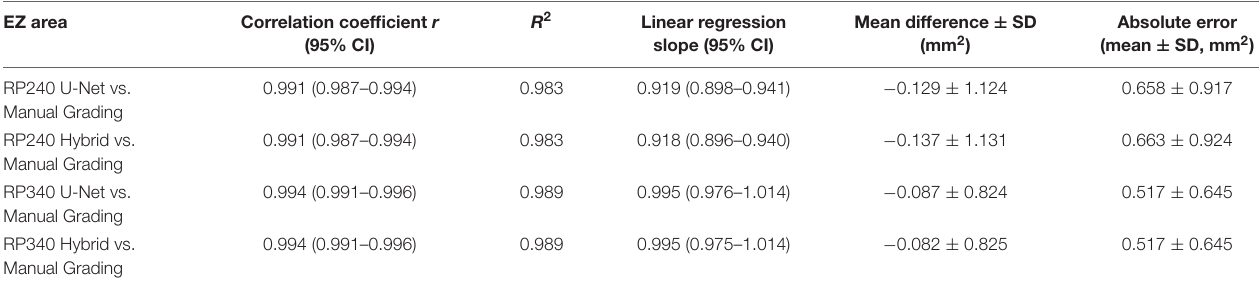
TABLE 1 | Summary of correlation coefficients, coefficients of determination ( R 2 ), linear regression slopes, mean differences, as well as mean absolute errors between ellipsoid zone (EZ) areas determined by the deep learning models and that of the reading center (human